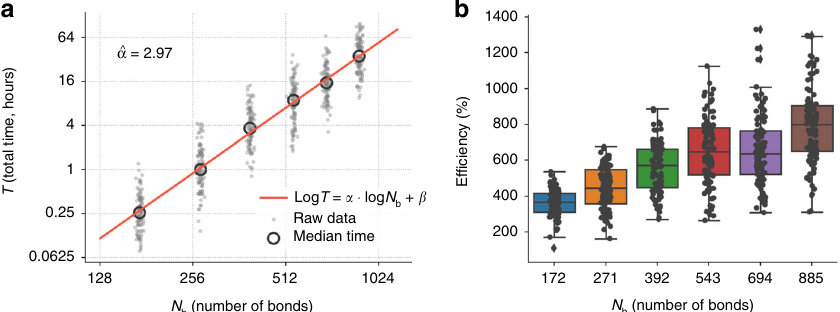
Fig. 3 Scaling of the algorithm. a Total execution time, in hours, versus number of bonds of a series of six increasingly large regular lattices. Empty large circles display the median execution time. Small gray dots show the raw data over 100 independent simulations. The red line is a linear fi t in logarithmic space. The panel shows that the algorithm scales approximately as the cube of the number of bonds. b Boxplot of displacement-based ef fi ciency as a function of number of bonds. The underlying raw data is also shown as black dots. Error bars in boxplots indicate minimum and maximum quartiles, boxes are fi rst and third quartiles. The panel shows that ef fi ciency initially increases with N b to then saturate, but there is great heterogeneity withing a fi xed lattice size.